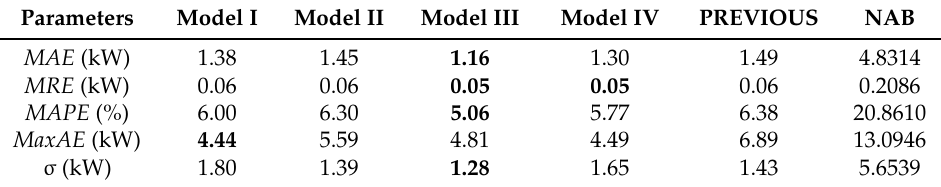
Table 20. Results obtained by neural network and NAB models over Test E, for a PH of 1 h. Parameters Model I Model II